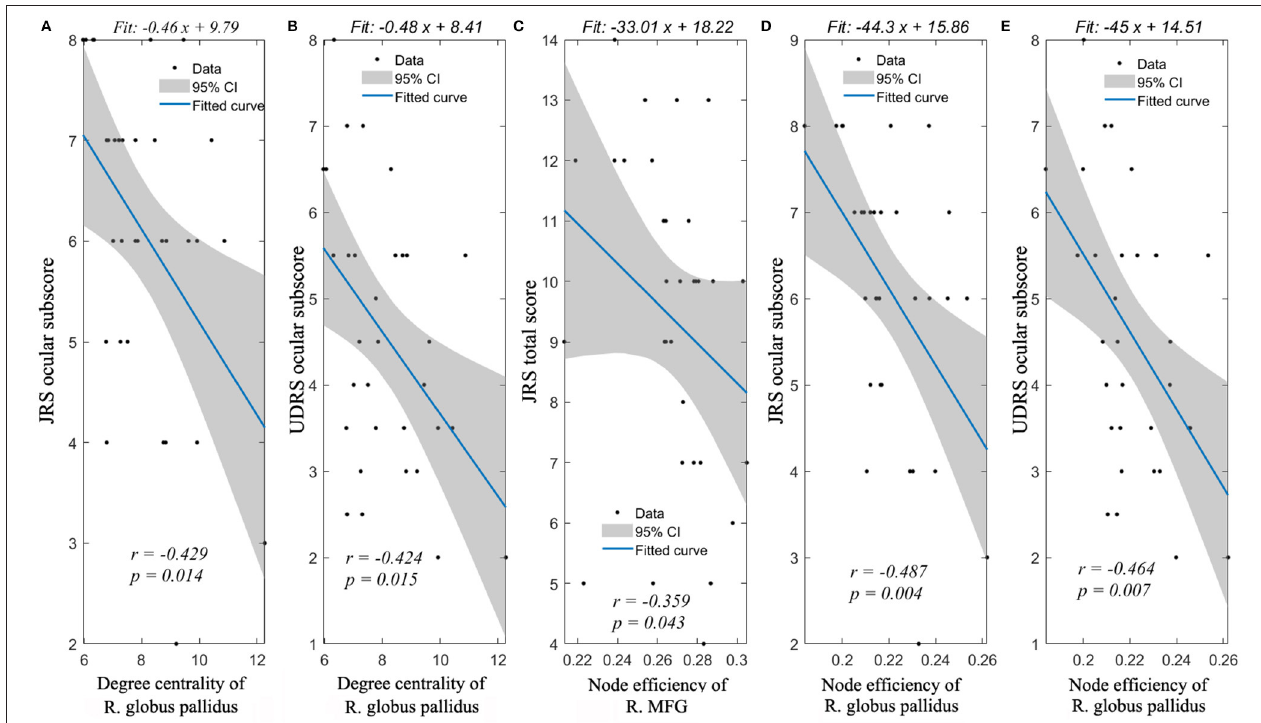
FIGURE 2 | Spearman’s correlation analyses between nodal properties and dystonia symptoms. Significant correlations could be found between JRS ocular subscore and degree centrality of R. globus pallidus (A) , UDRS ocular subscore and degree centrality of R. globus pallidus (B) , JRS total score and node efficiency of